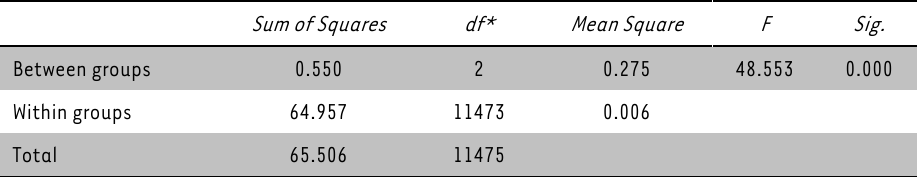
TABLE 5: Post-hoc comparisons of the means using the Tukey HSD test Mean Groups (I) Groups (J) Std. Error Sig. Difference (I-J) Native Gauteng Internal Migrants .0150** .00161 .000 .0146*# .00332 .000 Migrants Internal migrants Native Gauteng -.0150** .00161 -.0004 .00349 .993 Cross-border